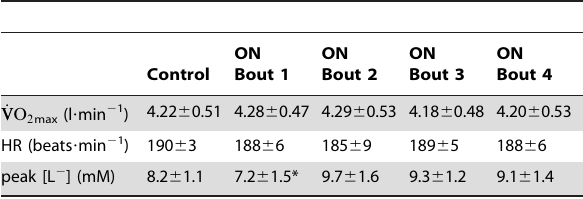
Table 2. _ VVO 2 max , HR and [L 2 ] attained at the limit of tolerance during the control and maximal HIIT protocols.